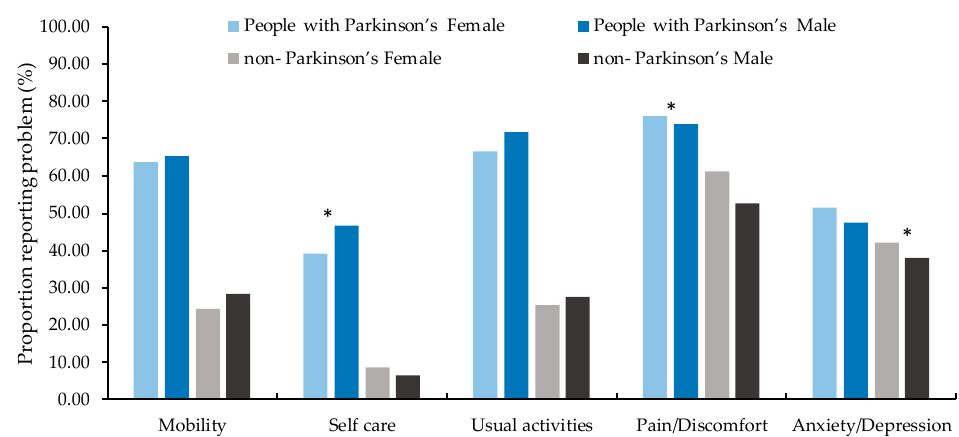
Figure 2. Frequency of reported problems for participants by gender at baseline ( n = 1654). * means significant difference ( p < 0.05) between two groups.